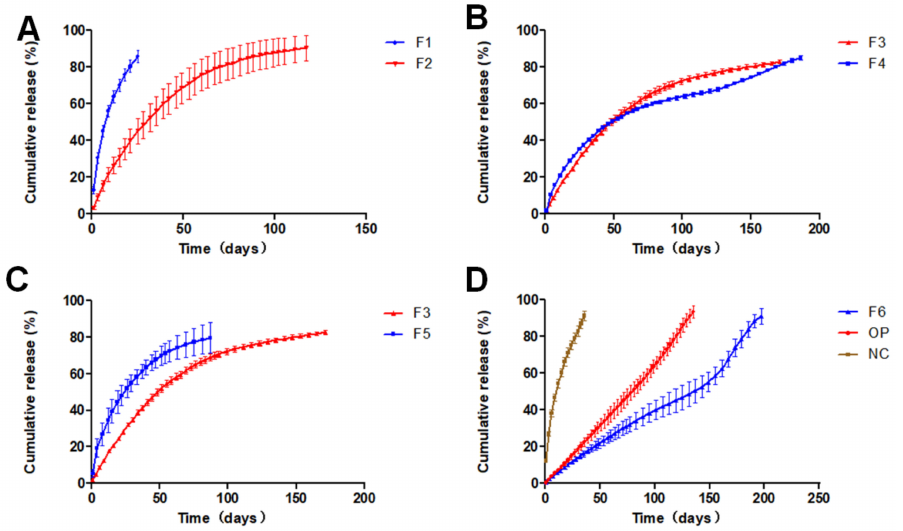
Figure 2. ( A ) Comparison of the dissolution of different pore formers on implants. ( B ) The effect of different risperidone/PLA ratios on the dissolution of implants. ( C ) The effect of different porogen concentrations on the dissolution of implants. ( D ) F6 was prepared using the single emulsion method; OP is the optimized formulation implant; NC is an uncoated optimized formulation